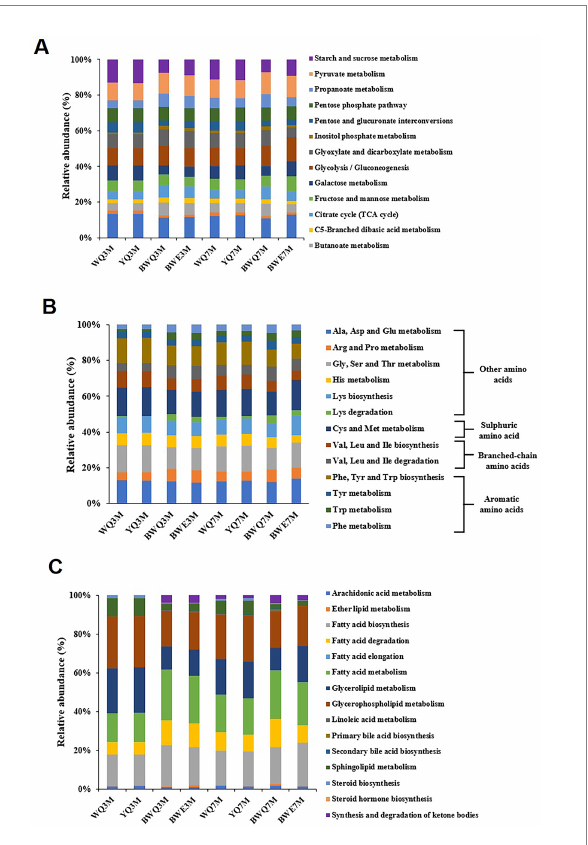
FIGURE 3 (A) Metabolic pathways of carbohydrates for different fish sauces. (B) Metabolic pathways of amino acids for different fish sauces. (C) Metabolic pathways of lipids for different fish sauces.